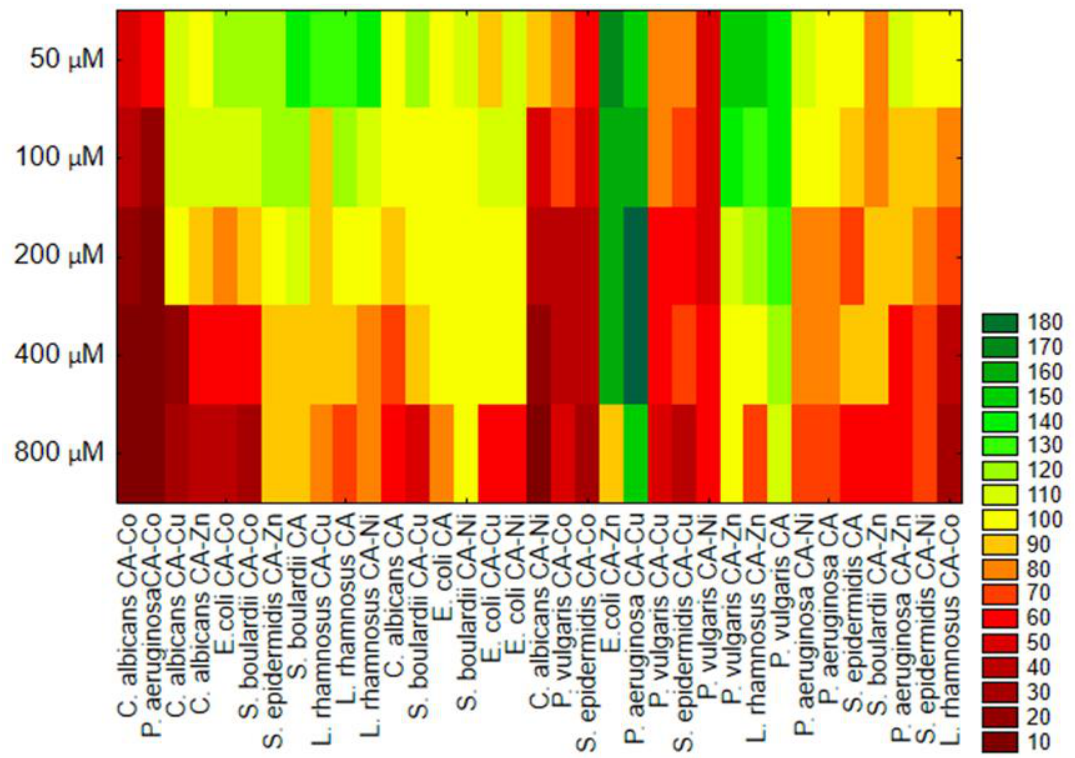
Figure 6. Cluster analysis for relative fungi and bacteria cells viability (%) after treatment of CA and its complexes with metals.